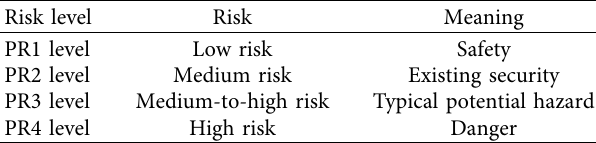
Table 1: Meanings of hazard